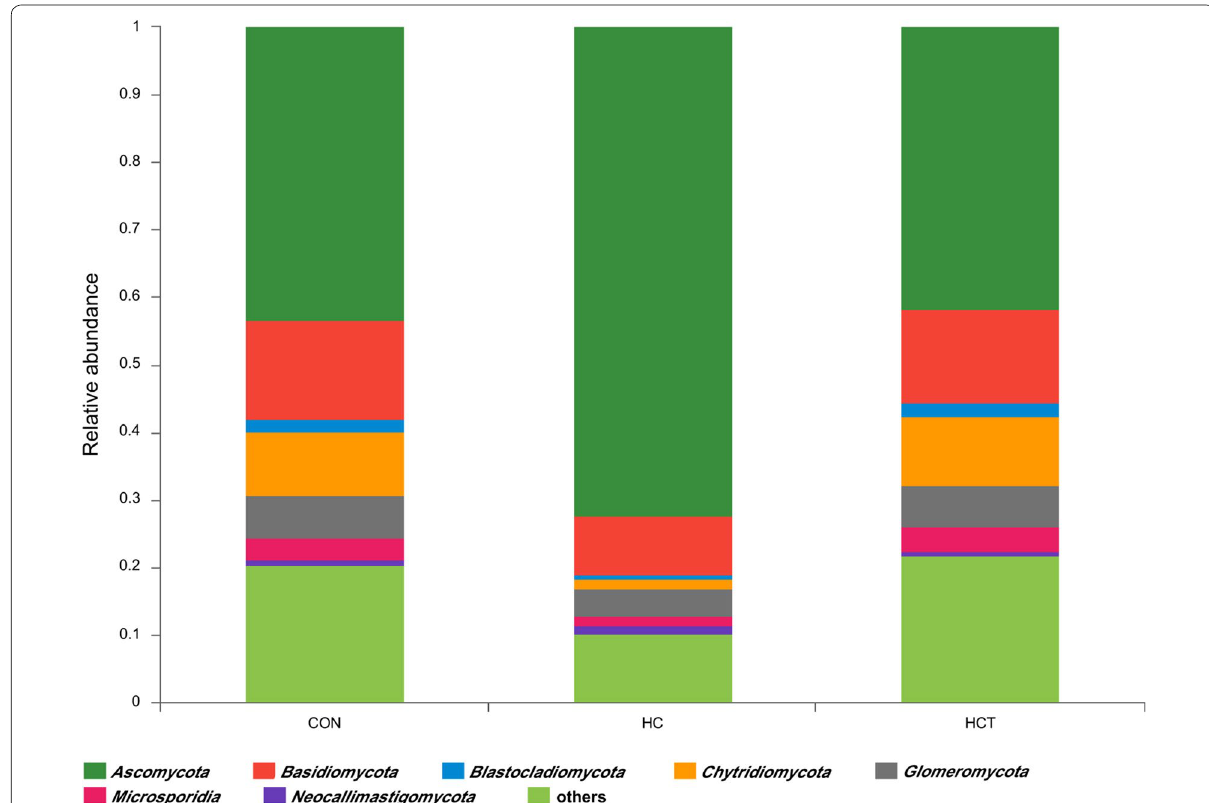
Fig. 2 Relative abundance of each ruminal fungi phylum for CON, HC and HCT treatments. CON, control diet; HC, high-concentrate diet; HCT, high-concentrate diet supplemented with 180 mg thiamine/kg DMI